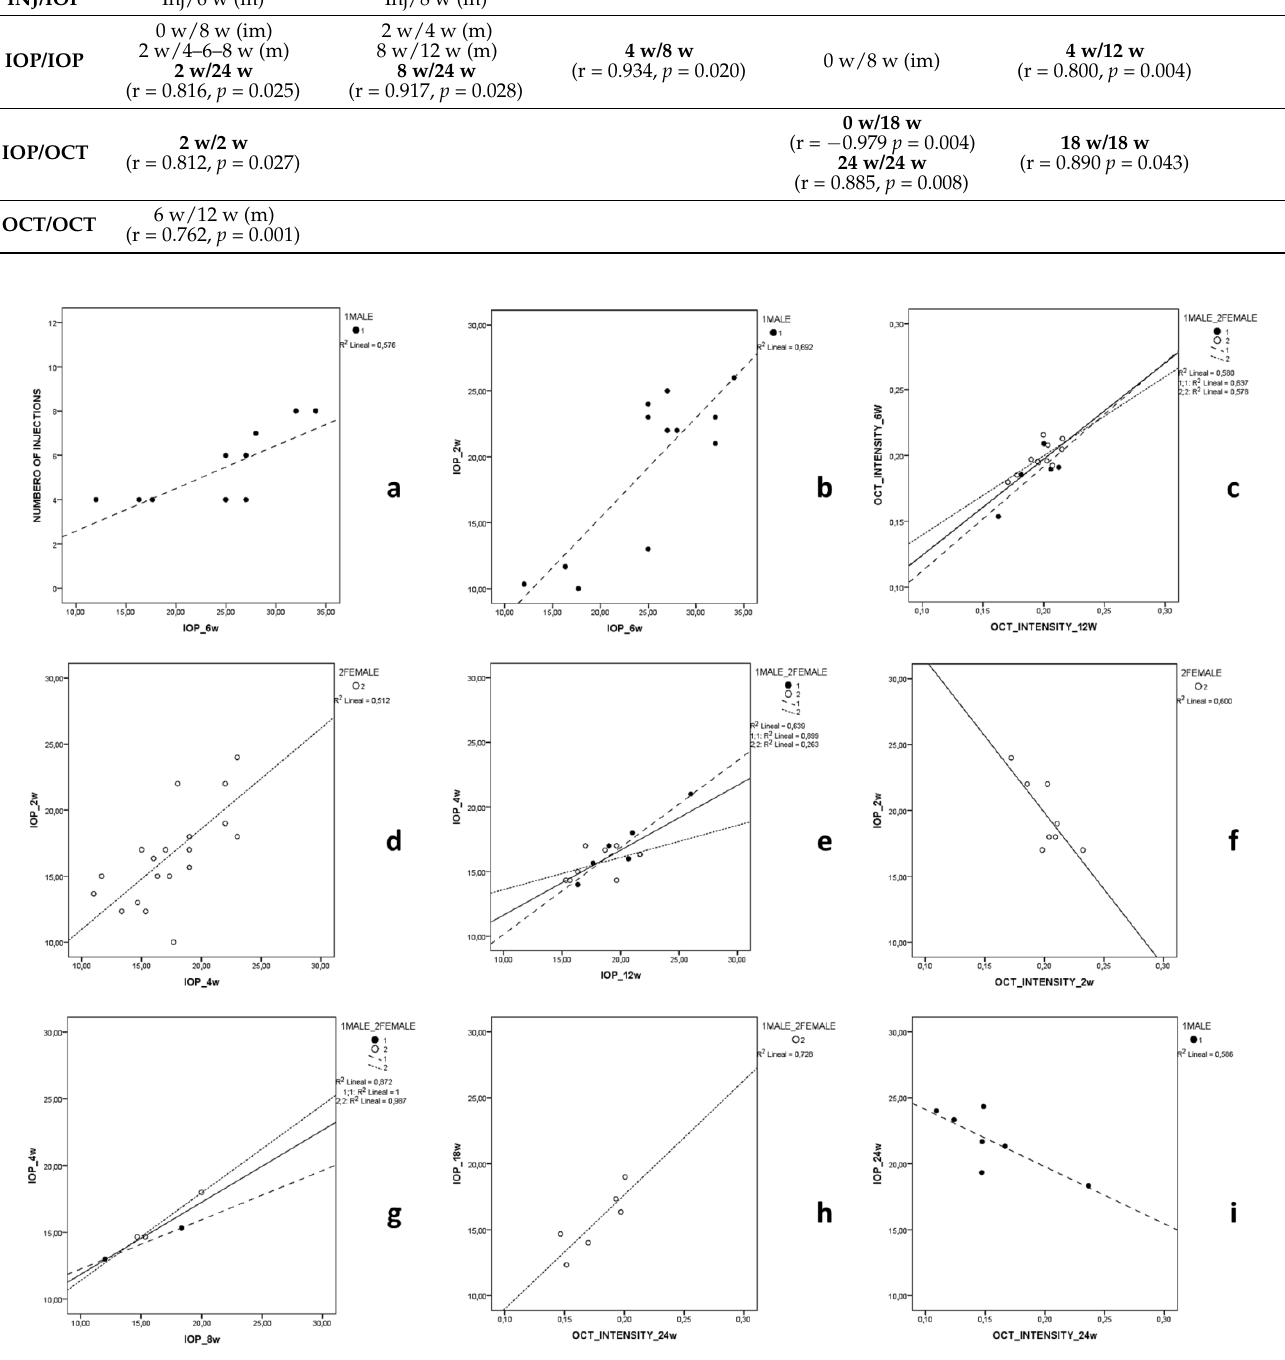
Figure 4. Significant correlations by sex in the two models of chronic glaucoma (episcleral model: ( a – c ); Ms model: ( d – f )); and healthy controls ( g – i ). Abbreviations: IOP: intraocular pressure; OCT: optical coherence tomography; w: